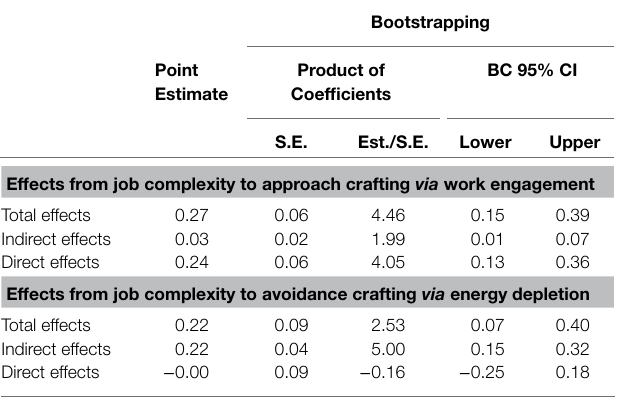
TABLE 4 | Path coefficients and indirect effects for mediation